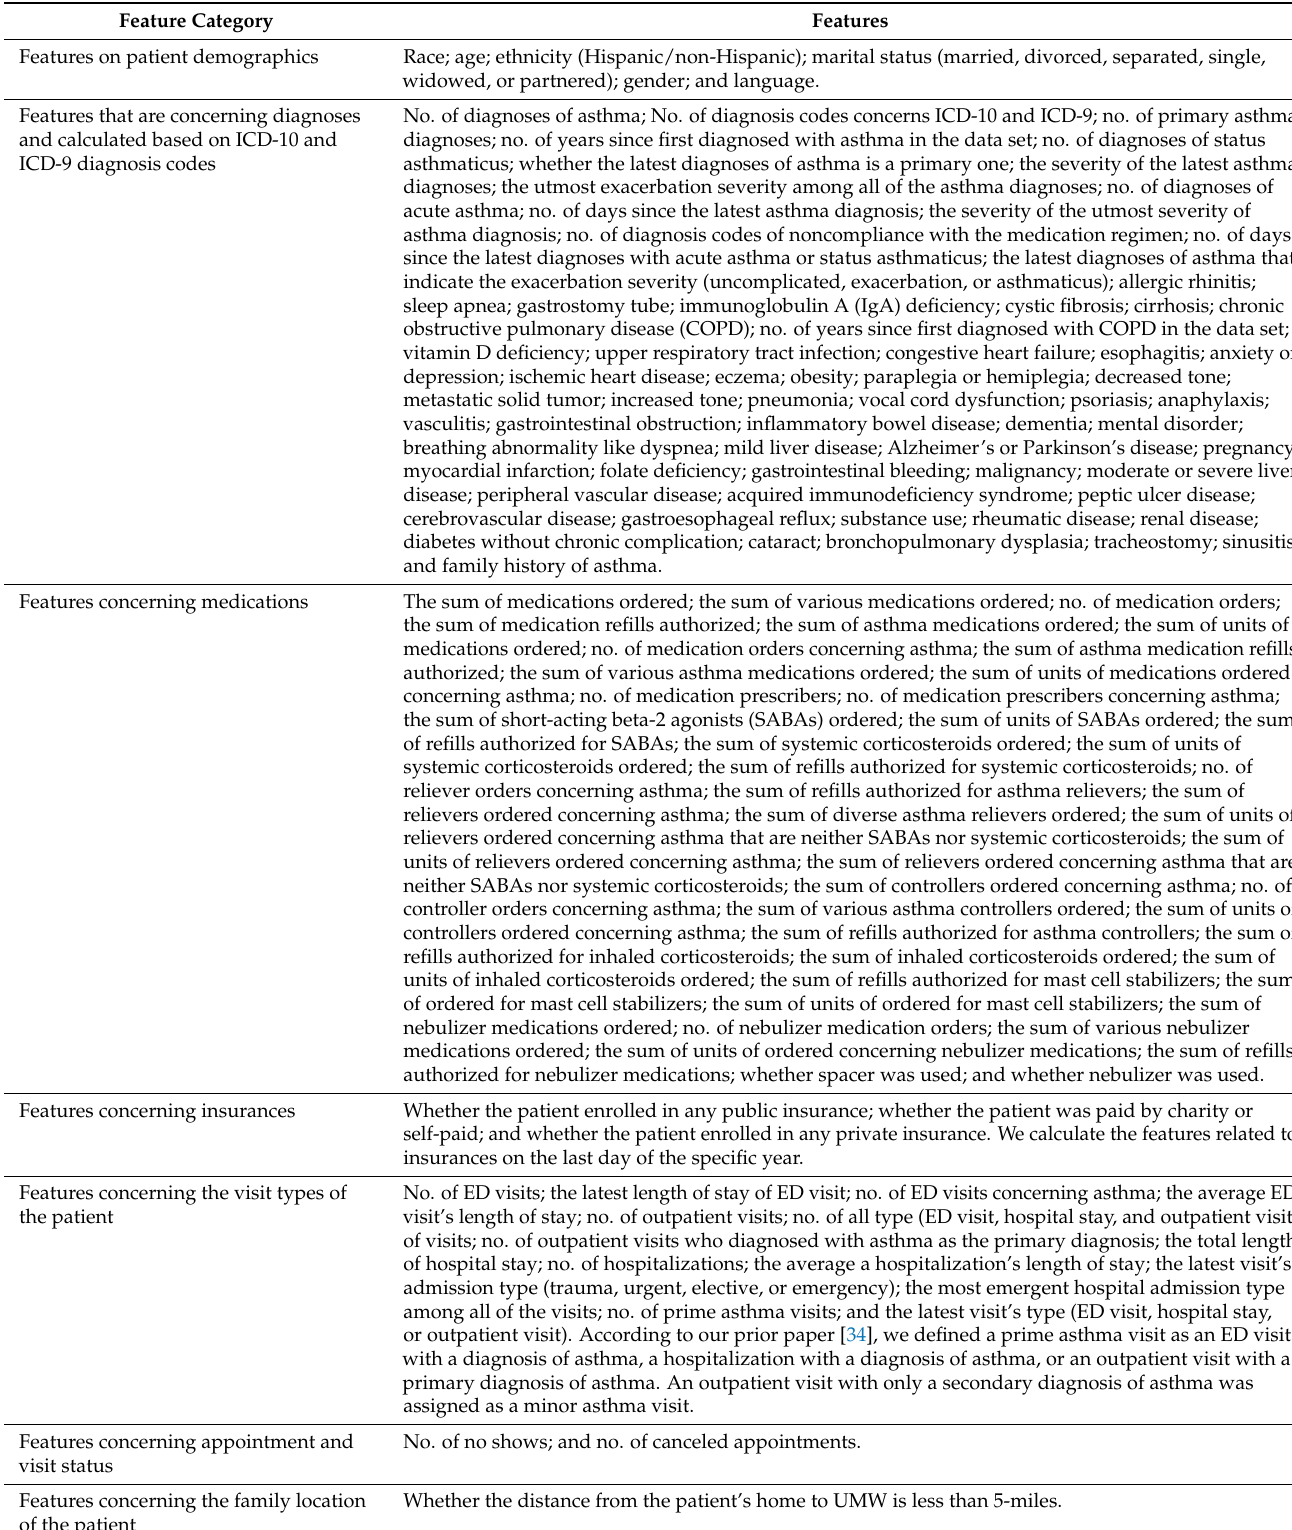
Table A1. The list of candidate features considered in the final